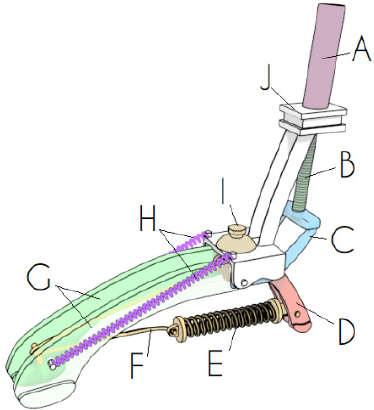
Figure 12. LPP active prosthesis.